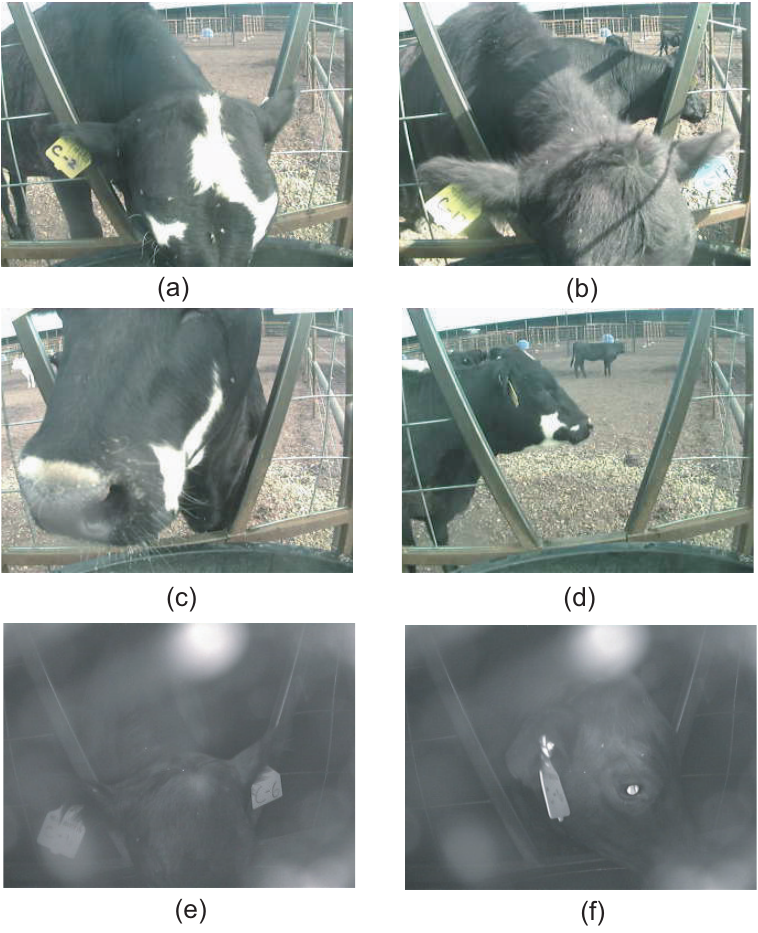
Figure 16. Image taken by the cameras triggered by motion detector: ( a ) Animal ID readable. ( b ) Animal ID not unreadable due to light. ( c ) Animal ID blocked. ( d ) False trigger of the camera with no drinking event. ( e ) Evening drinking event with animal ID readable. ( f ) Evening event with animal ID unreadable.